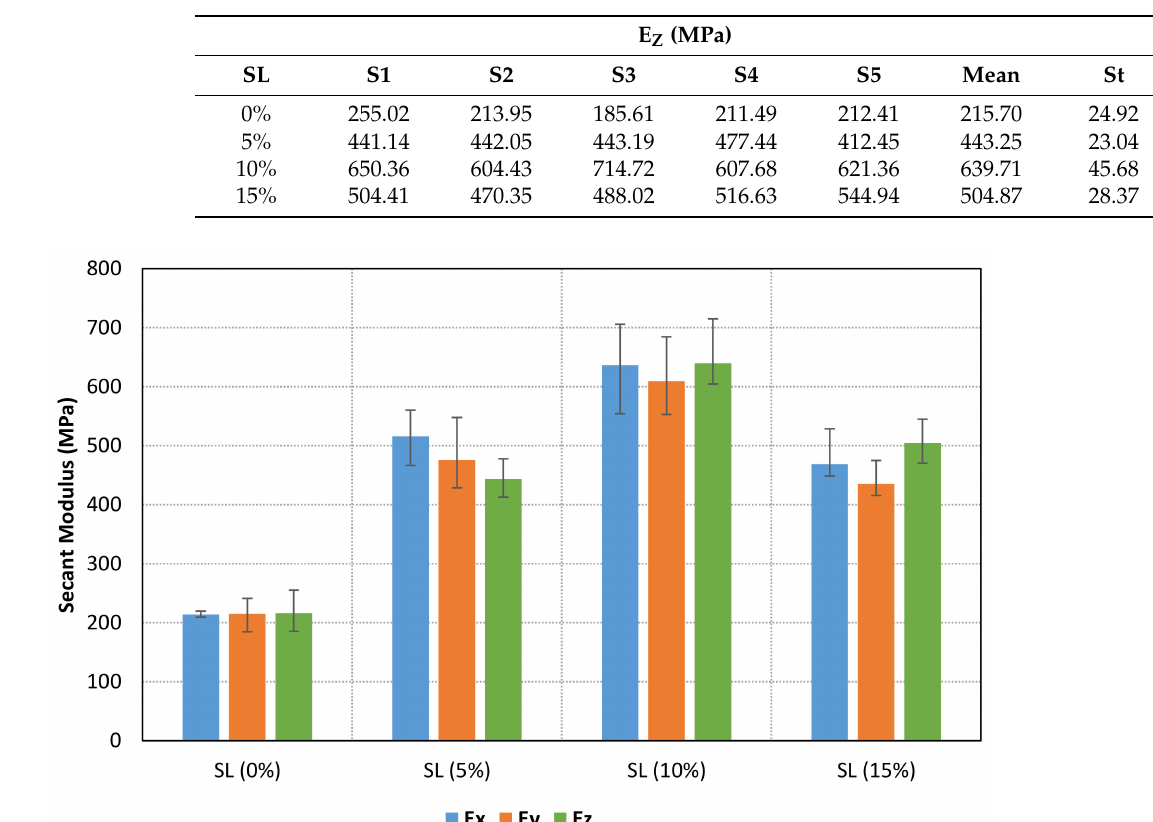
Figure 9. Secant modulus mean values for each printing orientation (X in blue, Y in orange and Z in green) according to the solid load content. It can be observed an enhancement of secant modulus after the addition of reinforcement particles.